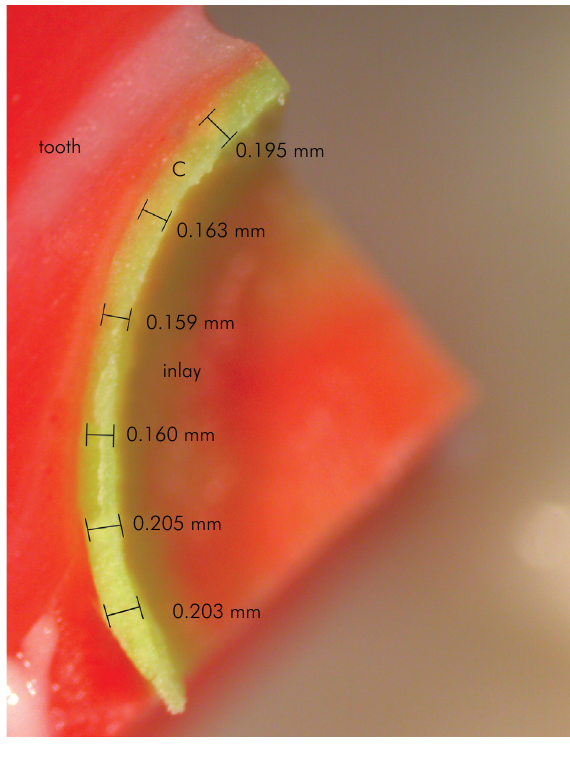
Figure 2. A representative stereomicroscopic image of the replica: six points were used to measure marginal adaptation of the inlay (C, cement line).